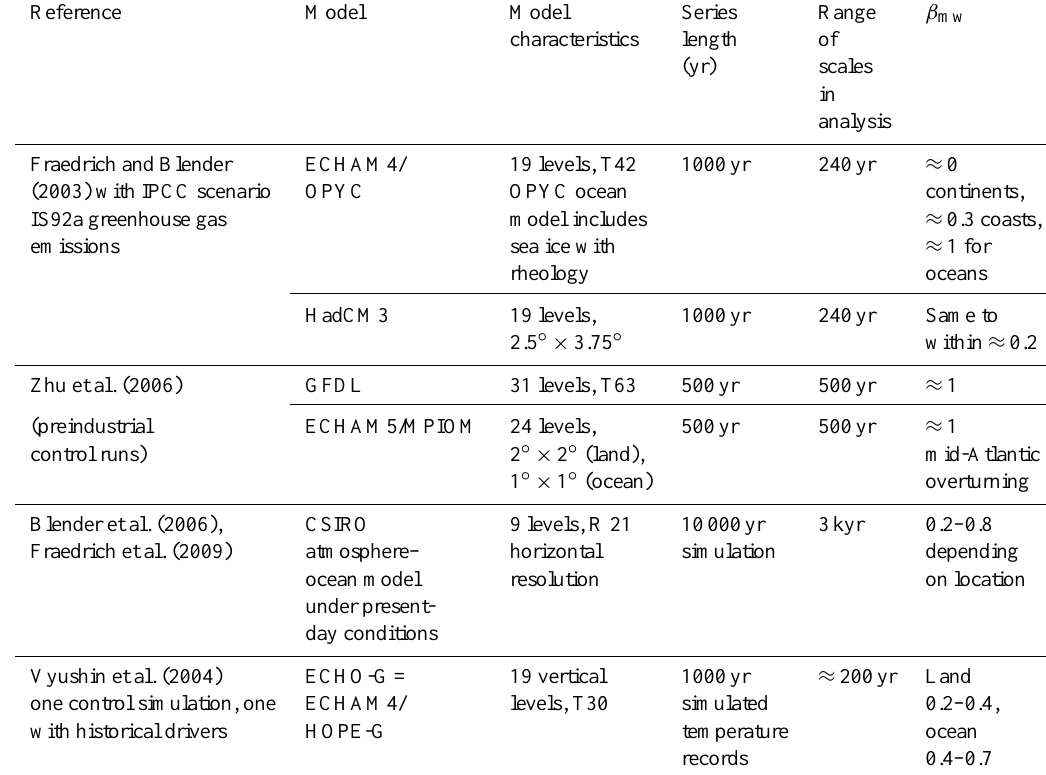
Table 2. Summary of scaling studies of GCM temperatures. All the estimates were made using the DFA method; the spectral exponent β was determined from β =2 α − 1, where α is the conventional DFA exponent (this expression ignores intermittency